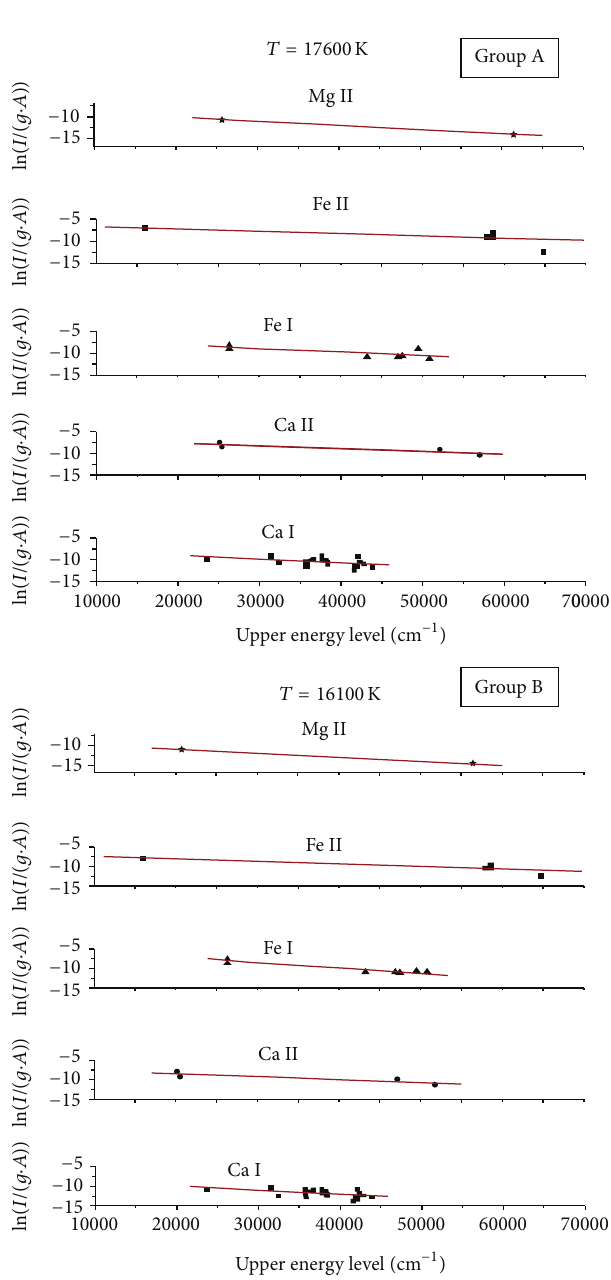
Figure 5: Boltzmann plots for different elements present in group A and group B.